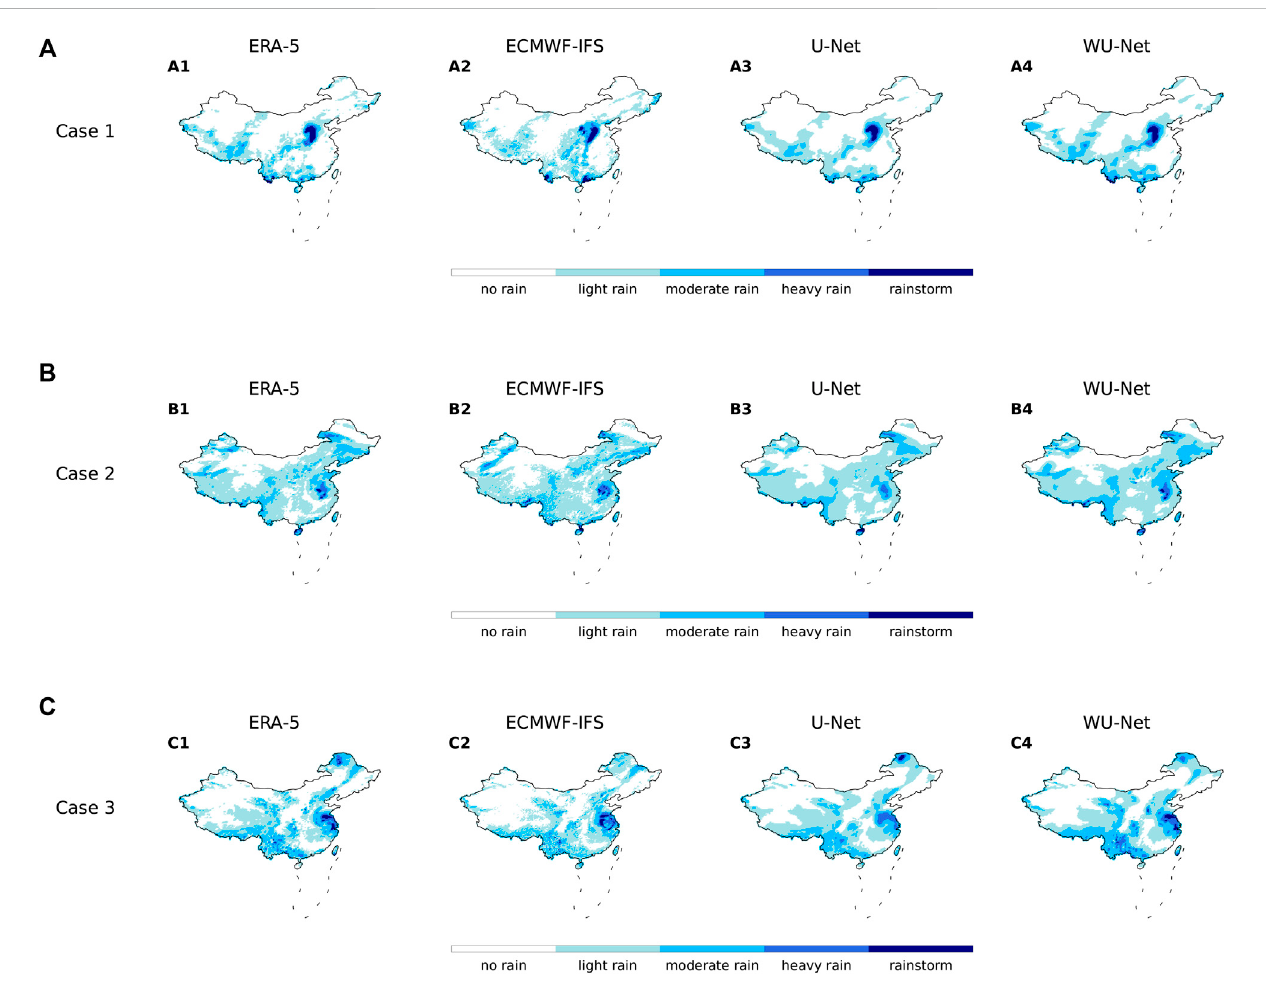
FIGURE 9 Examples of precipitation forecasts by different models. (A) 21/07/2021 0000 UTC, lead time 48 h. (B) 13/08/2018 0600 UTC, lead time 42 h. (C) 27/07/ 2021 1200 UTC, lead time 36 h.